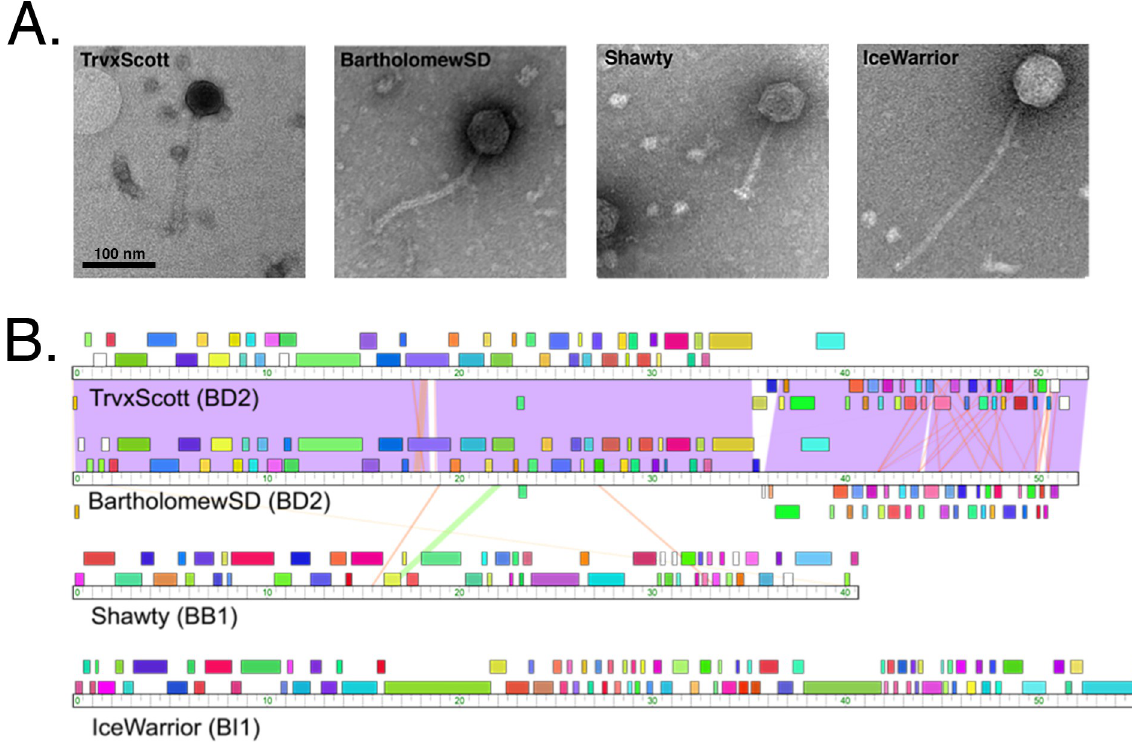
Fig 6. Characterization of four Streptomyces phages isolated from soil samples. ( A ) Electron micrographs of the four phages (IceWarrior, TrvxScott, BartholomewSD, and Shawty). Lysate samples were negatively stained and imaged with transmission electron microscopy (TEM). The scale bar represents 100 nm. ( B ) A whole-genome sequence comparison of the four phages generated by Phamerator (top to bottom: TrvxScott, BartholomewSD, Shawty,